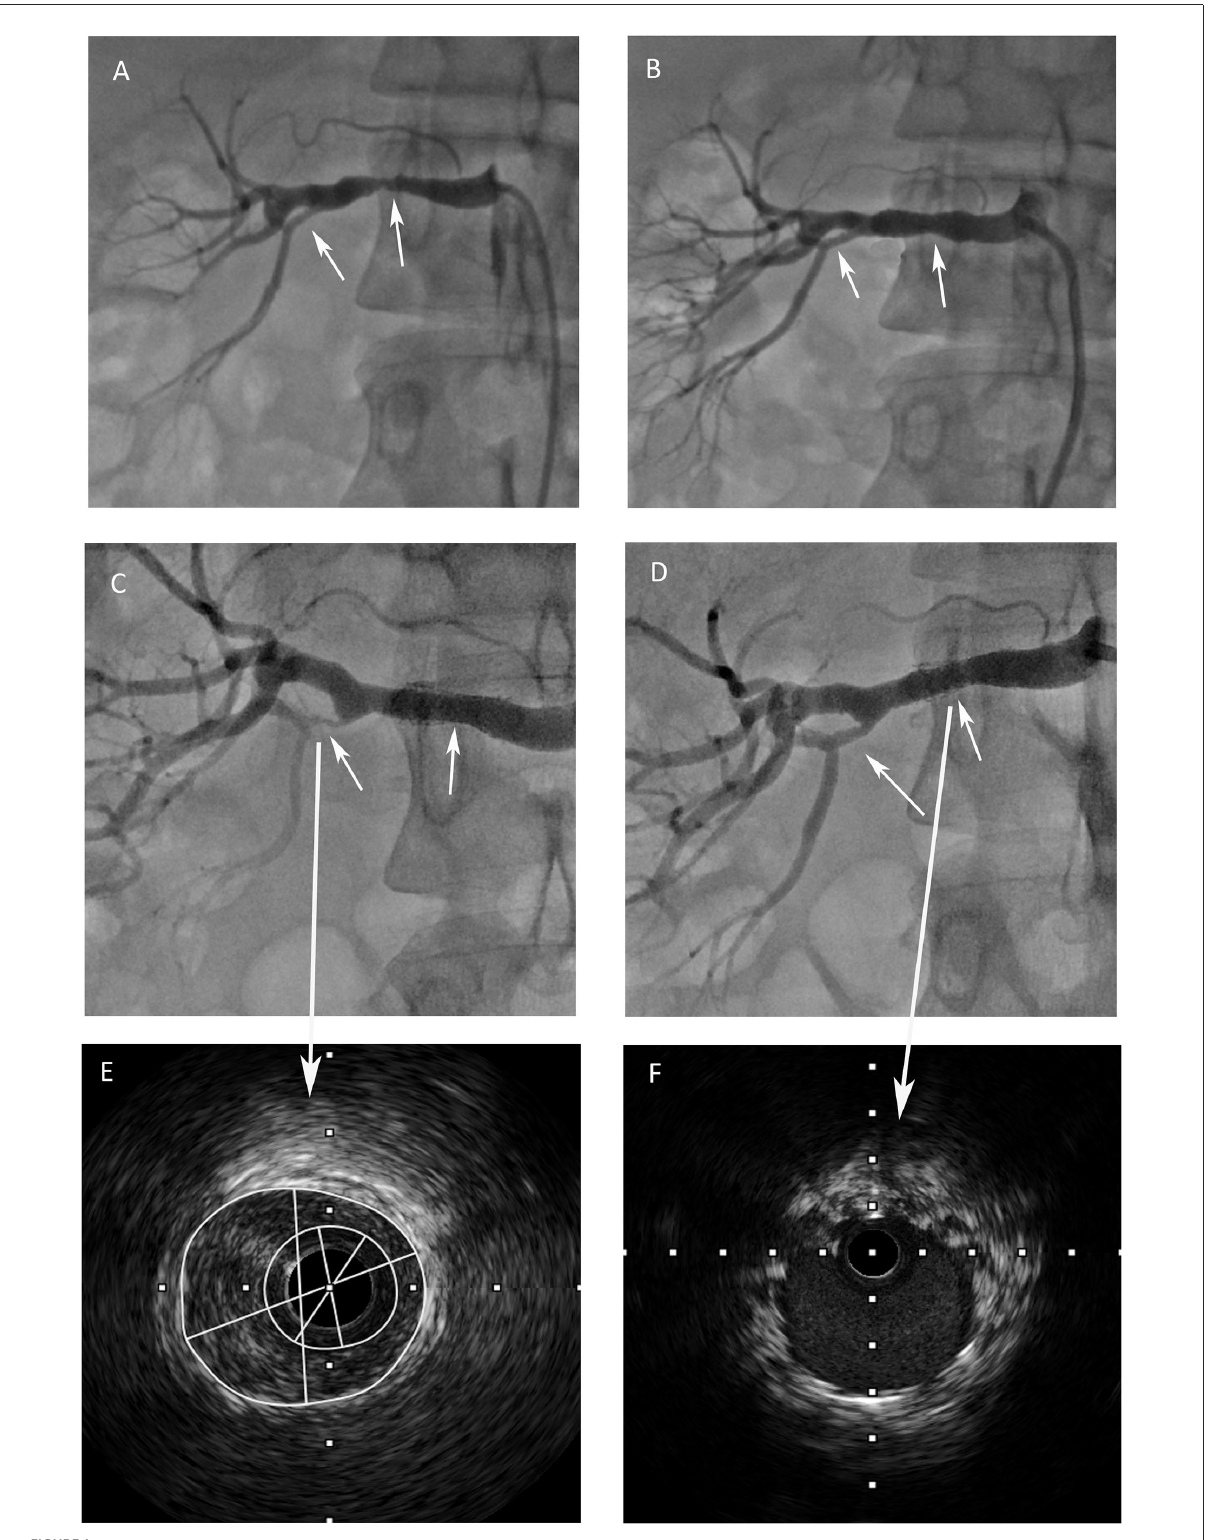
FIGURE1 (A) Renal angiography revealed focal stenosis in the mid-portion of the right renal artery and the right inferior renal branch artery was normal. (B) After a stent was implanted into the renal artery, the right inferior renal branch artery was still normal. (C) Severe stenosis was found in the right inferior renal branch artery, no obvious in-stent restenosis was observed. (D) The lesion vessel was dilated successfully and the renal blood flow was restored after the procedure. (E) Intravascular ultrasound image revealed eccentric intimal thickening of the branch artery. (F) Intravascular ultrasound image revealed that no obvious neointimal hyperplasia in the